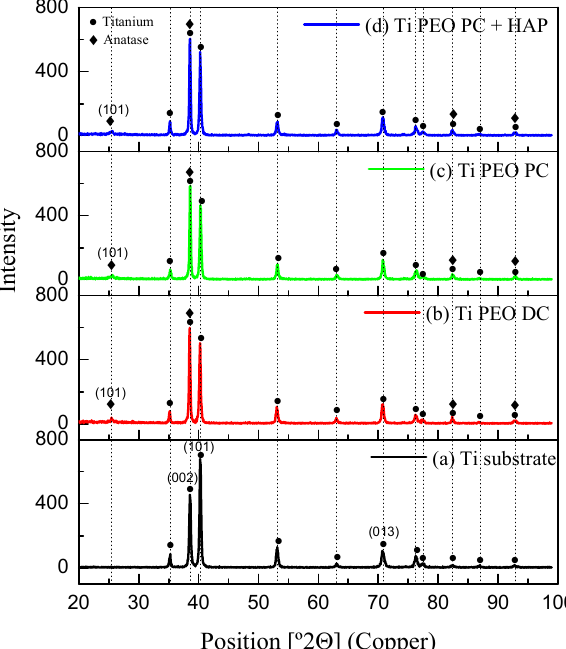
Figure 4. EDS spectra of Ti-based samples: ( a ) Ti PEO DC; ( b ) Ti PEO PC; ( c ) Ti PEO PC + HAP.